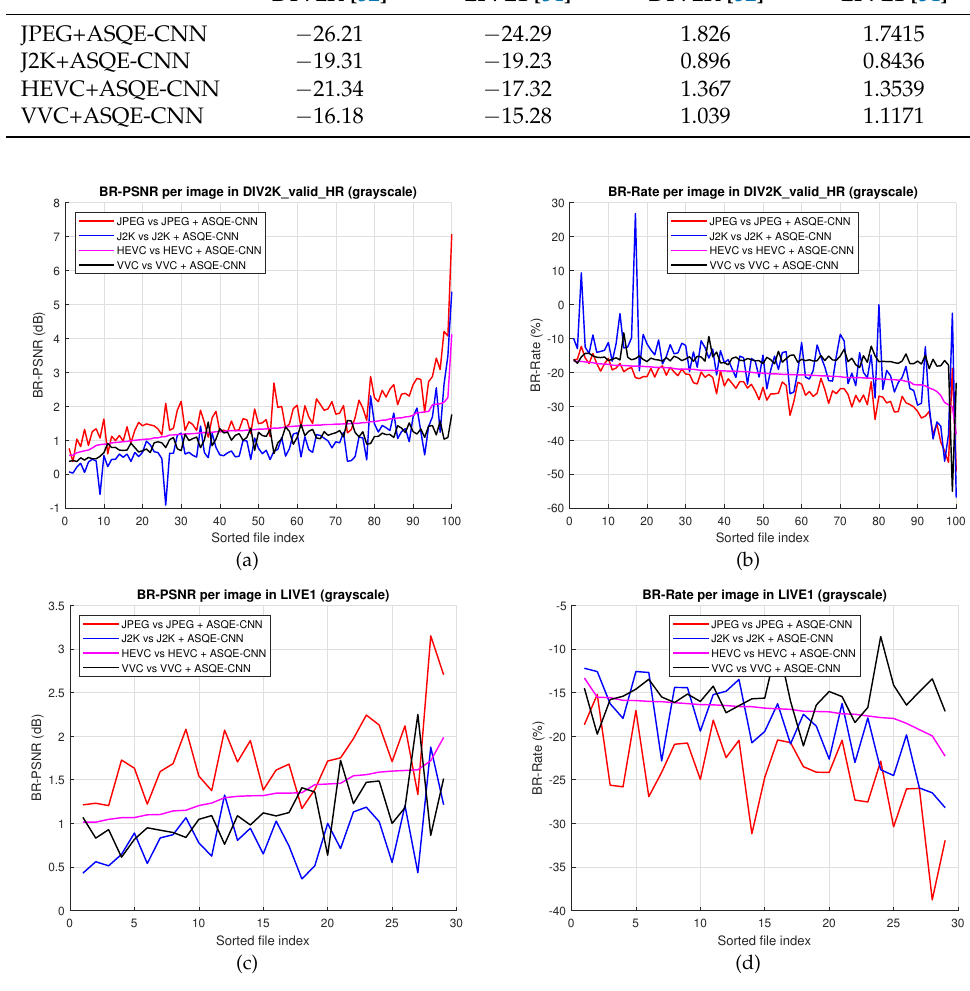
Figure 10. BD-PSNR results for every image in ( a ) DIV2K_valid_HR [52] and ( c ) LIVE1 [54]. BD-rate (%) results for every image in ( b ) DIV2K_valid_HR [52] and ( d ) LIVE1